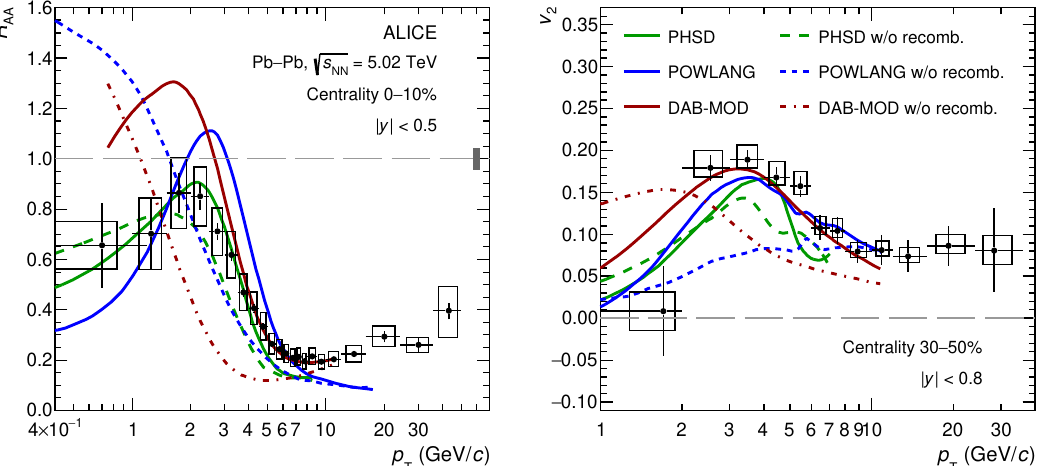
Figure 13 . Prompt D-meson R AA in the 0–10% centrality class (left panel) and v 2 in the 30–50% centrality class (right panel) compared with the PHSD [125], POWLANG [117, 118], and DAB- MOD [116] predictions obtained with and without including hadronisation via